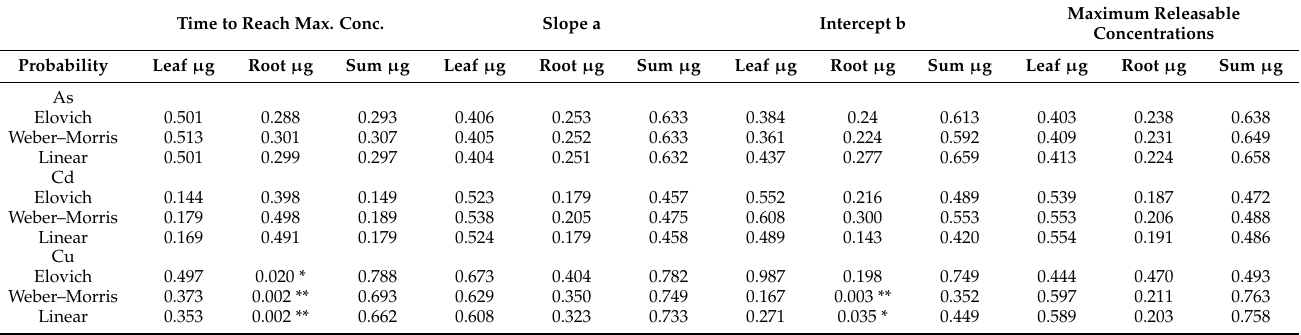
Table 5. Probability values between the contents in cropped lettuce and the kinetic parameters obtained from modelling the EUF